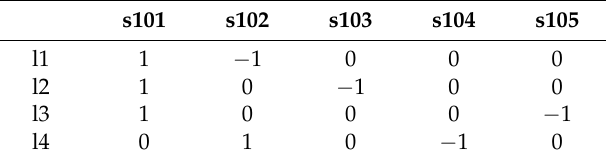
Table A16. Line map, line_map( l , s ).